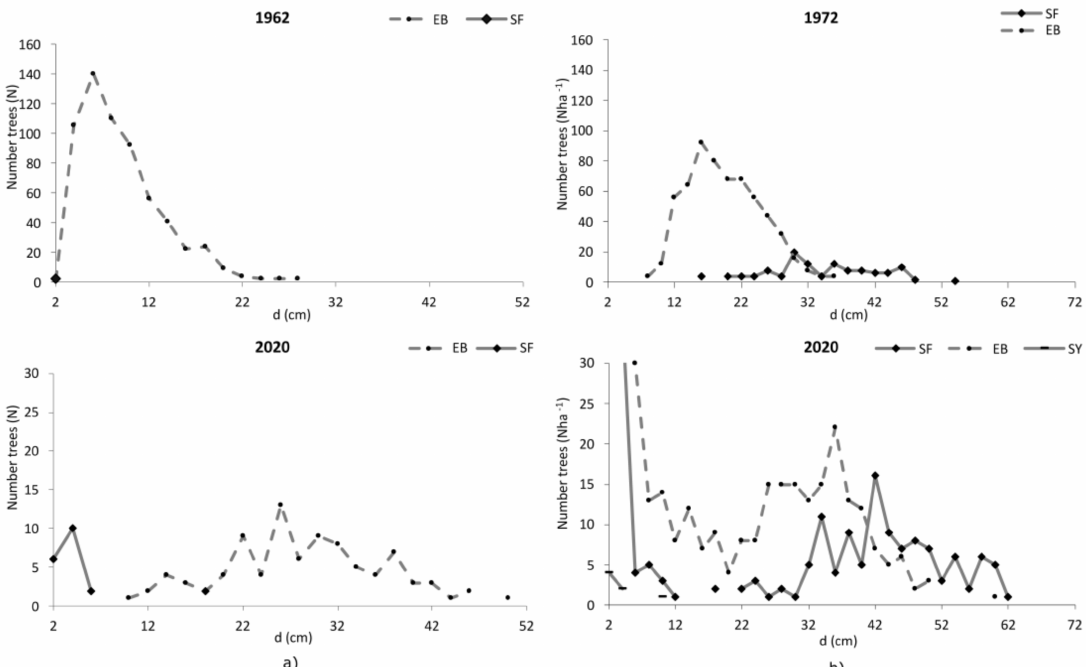
Figure 2. Frequency distributions of tree diameter in beech ( a ) and mixed fir–beech ( b ) stands over the last several decades (1962/1972–2020). EB—European beech, SF—silver fir, and SY—sycamore. In the pure beech stand ( a ), 50 years ago, in the sample area, there were only two fir trees with diameters of 2 cm. Now, those trees have diameters of 16 and 18 cm and a second fir floor is already developing in the stand. In the fir–beech stand ( b ), over 50 years, a vigorous stand of fir and beech (around 50,000 seedlings per hectare) have been installed. The data are from the complete inventory performed on 0.25 ha (for the stand in Figure 2a) and on 1.0 ha (for the stand in Figure 2b). See Supplementary Material (Tables S1 and S2), S27 and